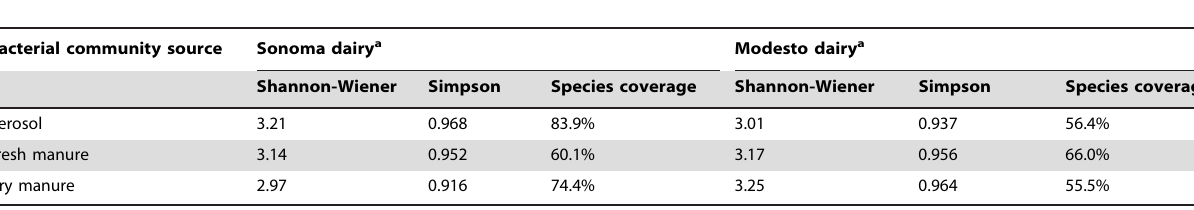
Table 3. Species diversity and richness of bacterial communities in aerosol and manure samples from two different dairies.